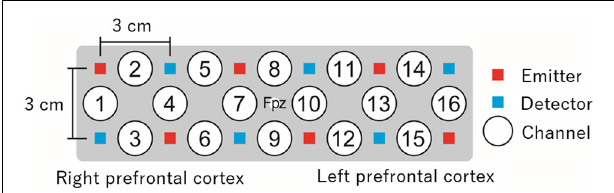
FIGURE 1 | An example of prefrontal measurement with 16-channel NIRS. In this example, a holder is placed on the head surface such that its center matches the Fpz location in the international 10–20 system. Changes in oxyHb and deoxyHb concentrations are measured from approximately 2 cm below the scalp by 16 independent channels. NIRS, near-infrared spectroscopy; oxyHb, oxygenated hemoglobin; deoxyHb, deoxygenated